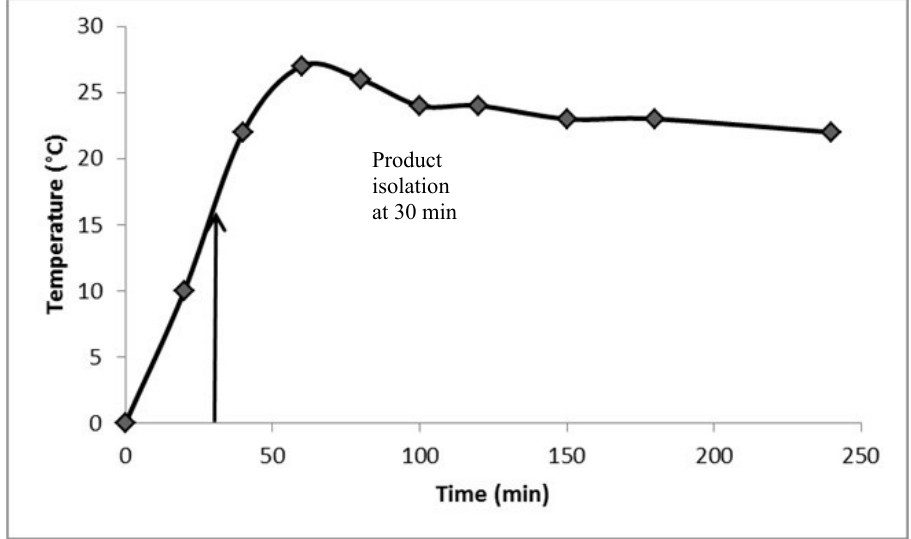
Figure 1. Temperature change after quenching a 100-gram scale